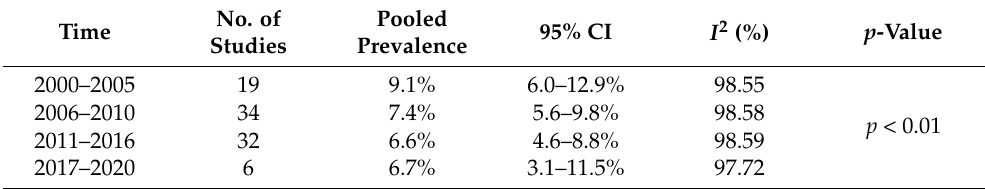
Table 3. Subgroup analysis of the prevalence of L. monocytogenes at different time periods. No. of Pooled Time 95% CI I 2 (%) p Studies Prevalence